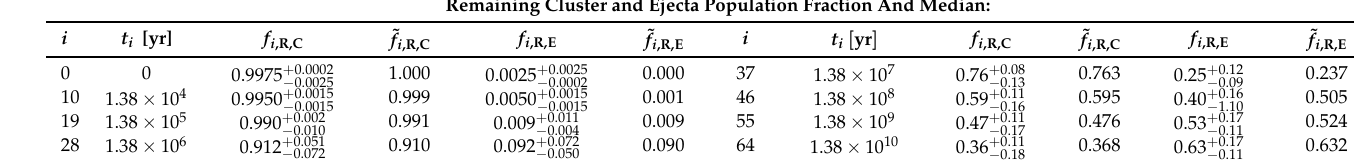
Table 6. Mean remaining in-cluster and in-ejecta object population fractions ˜ f i ,R,P and median ˜ f i ,R,P where P = ( C,E ) . The fraction is centred around the mean and shown are the 95% C.B. and is computed along with the median by averaging over the N R = 5000 realisations at selected